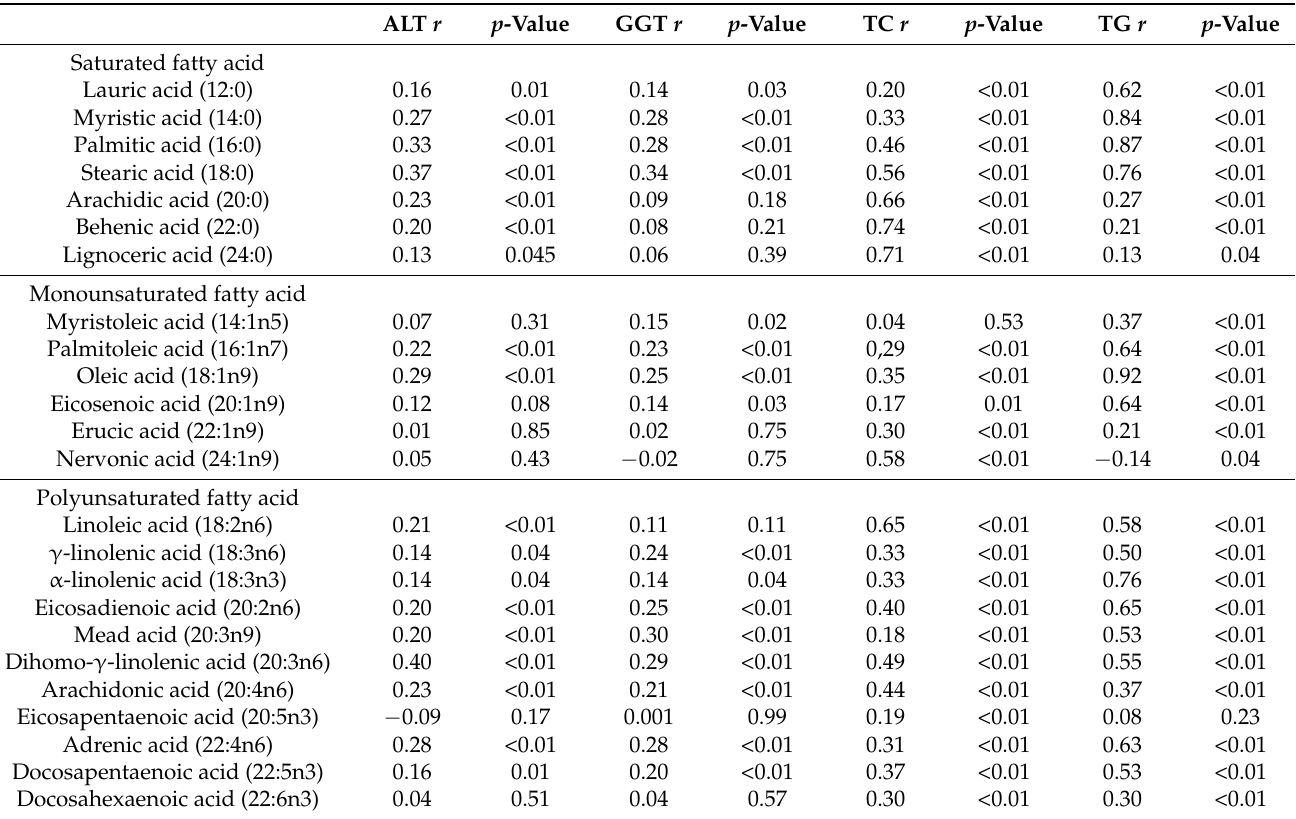
Table 4. Correlations between fatty acids and clinical